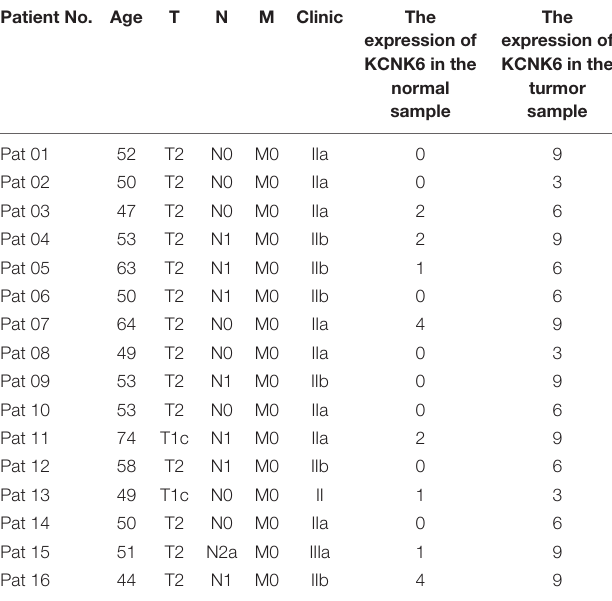
TABLE 1 | Clinical patient information KCNK6 expression in breast cancer tissues and corresponding adjacent tissues of paraffin-embedded tissue sections. Patient No.